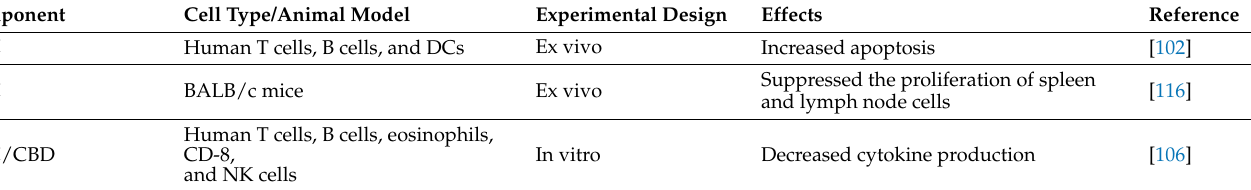
Table 1. The effects of cannabinoids and agonists/antagonists of CBR-1/2 on immune cells. Component Cell Type/Animal